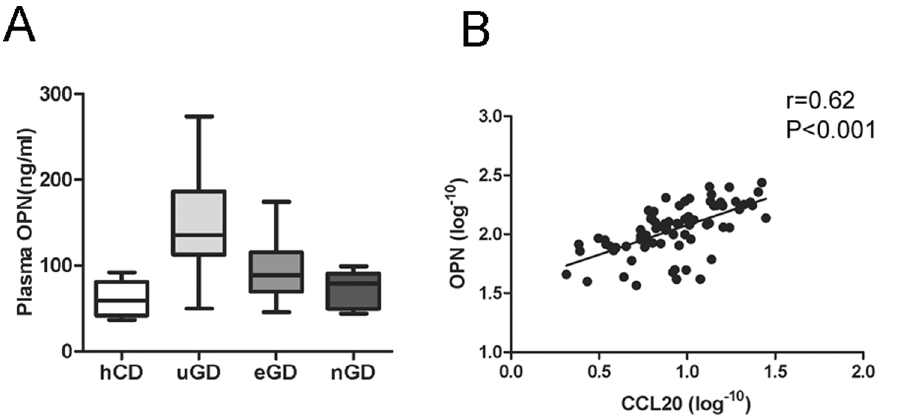
Figure 2. Plasma OPN levels in GD patients and normal controls and the correlation between plasma CCL20 with OPN. (A) Distribution of plasma OPN levels in 35 healthy control donors, 50 untreated GD patients, 15 euthyroid GD patients and 12 TRAb-negative GD patients. Median values, interquartile ranges and ranges are denoted by horizontal bars, boxes and vertical bars, respectively. (B) Regression scatter plots showing the correlation between logarithm-transformed plasma CCL20 level and logarithm-transformed plasma OPN level. The correlation shown was significant ( r =0.62, P , 0.001).